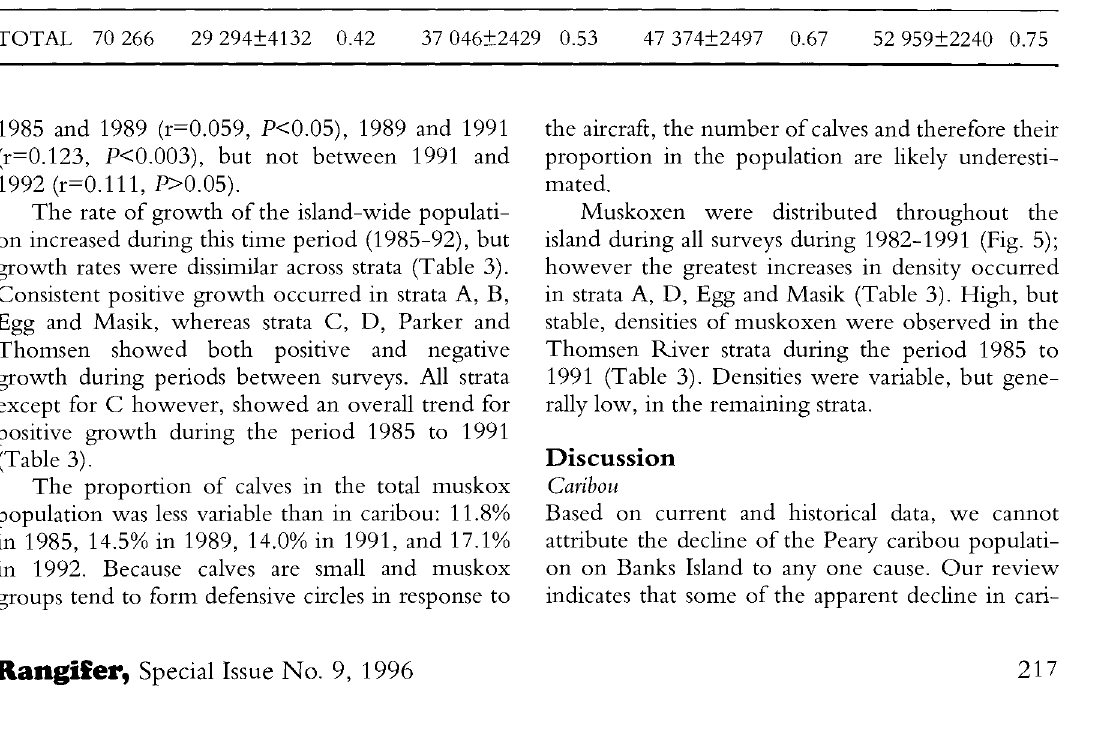
Table 3. Estimates (1SE) and densities of muskoxen (excluding calves) based upon restratified data from 1985, 1989, 1991, and 1992 population